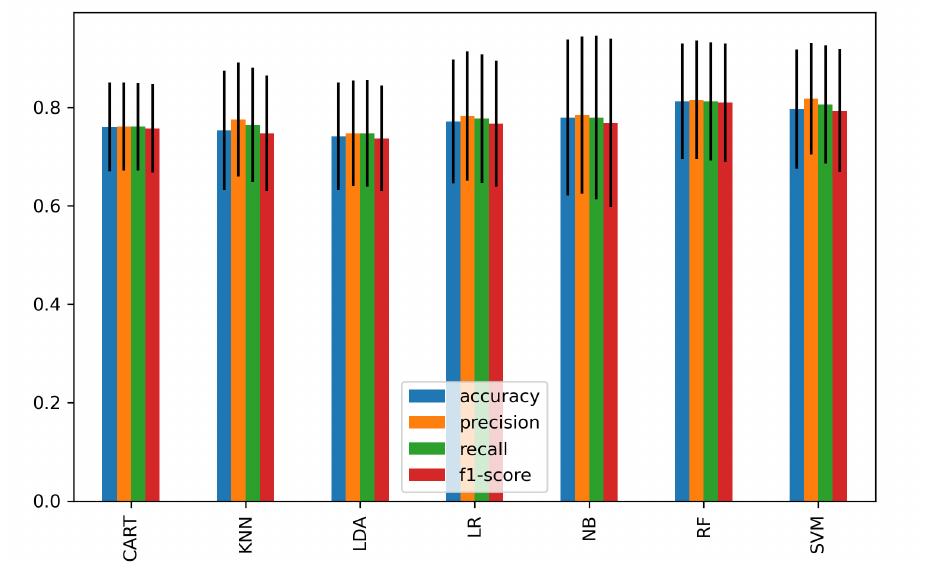
Figure 8. The average classification performance and standard deviation σ of 15 significant features of the time domain. The vertical line indicates σ .